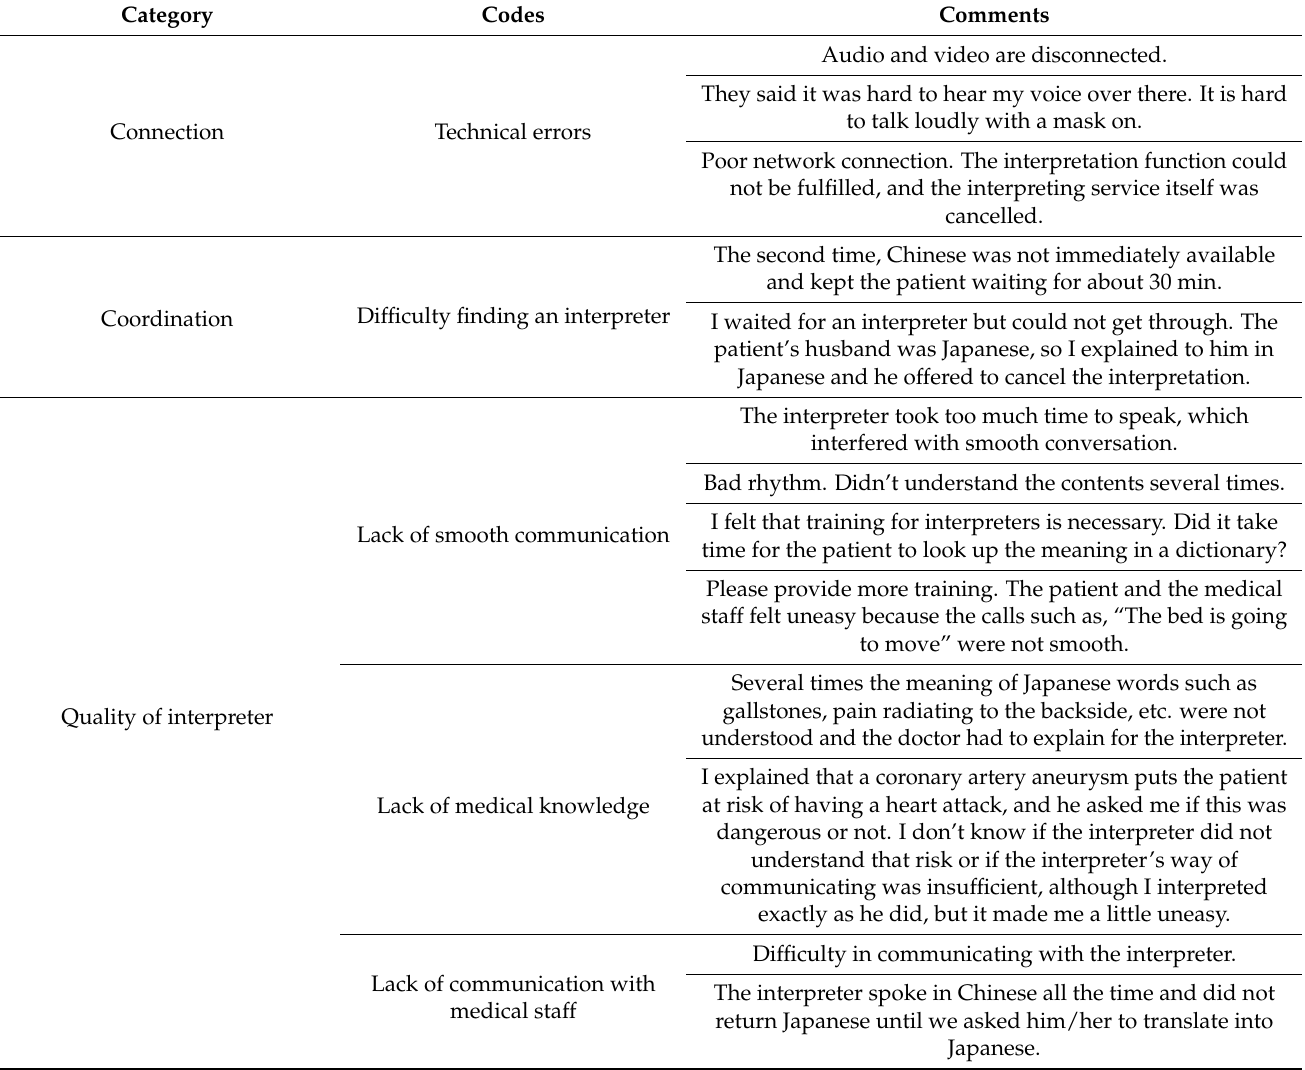
Table 6. Feedback of the healthcare providers to the remote medical interpreting